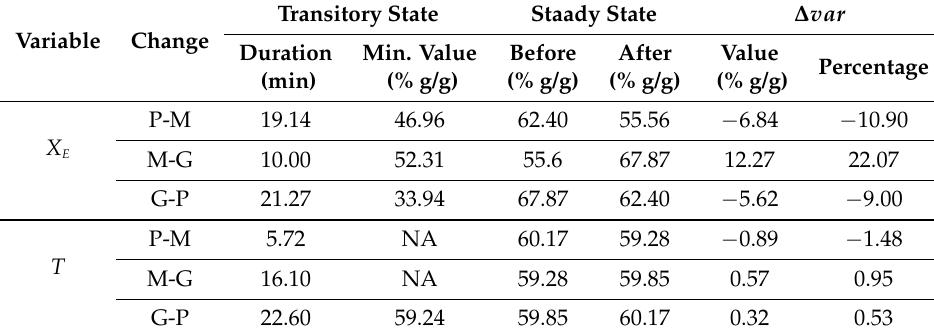
Figure 5. Effect of the oil changes in the mass fraction of esters. Table 4. Disturbance effects of oil change in the reactor.